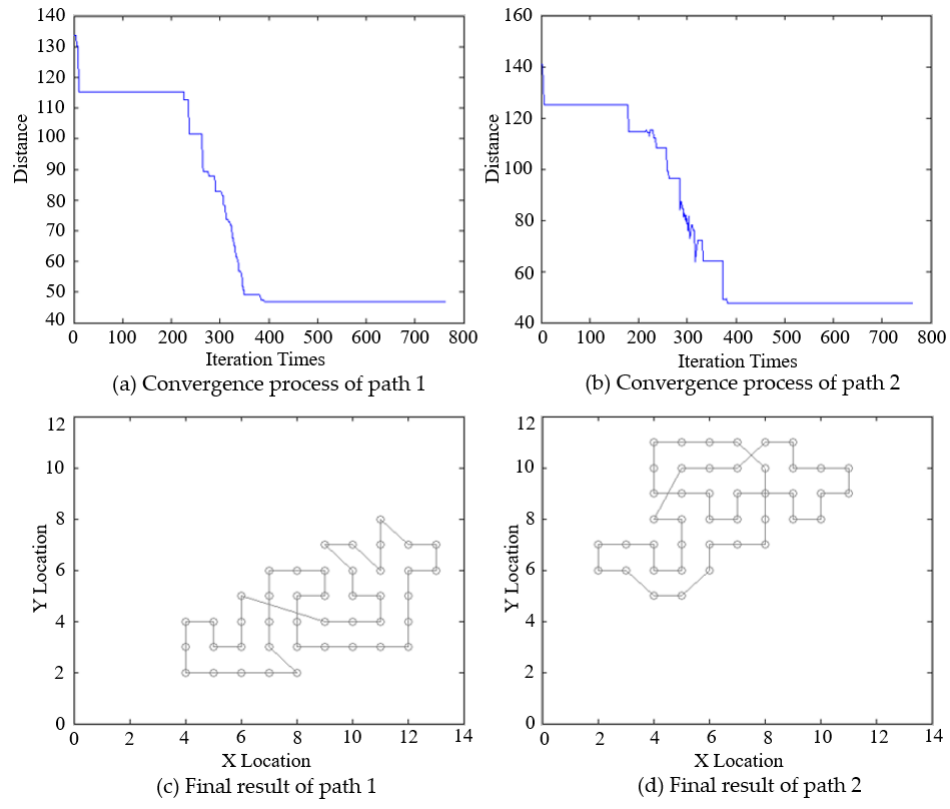
Figure 9. Convergence processes and final results of the SAA paths. The previews and actual trails for the two different paths are shown in Figure 10. There is a little difference between ideal paths and actual paths due to the inertia of the UAVs and the location error of the GPS system. This difference is acceptable because some image redundancy has been reserved in the image overlapping.